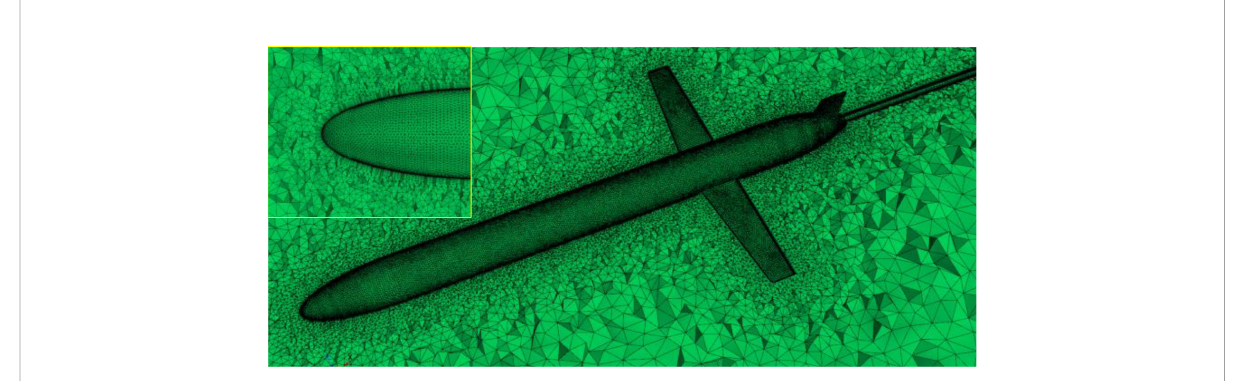
FIGURE 8 Mesh map of computational domain and surface for Petrel-L.